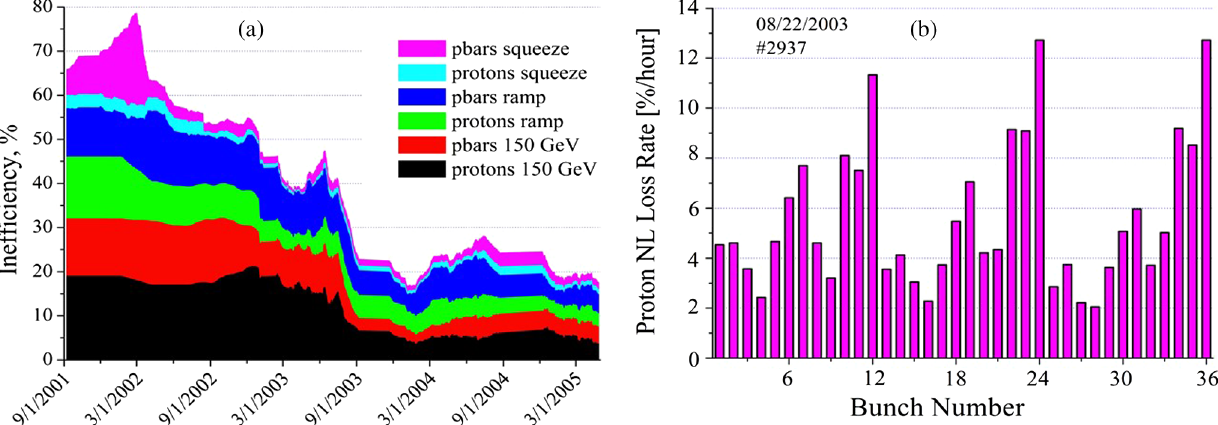
FIG. 5. (a) Left: Improvements of the Tevatron operational inefficiencies (ratios of the total bunch intensities after and before various stage) in 2001 – 2005; (b) right: nonluminous loss rate of proton bunch intensity at the beginning of store #2973 (August 22, 2003) – from Ref.